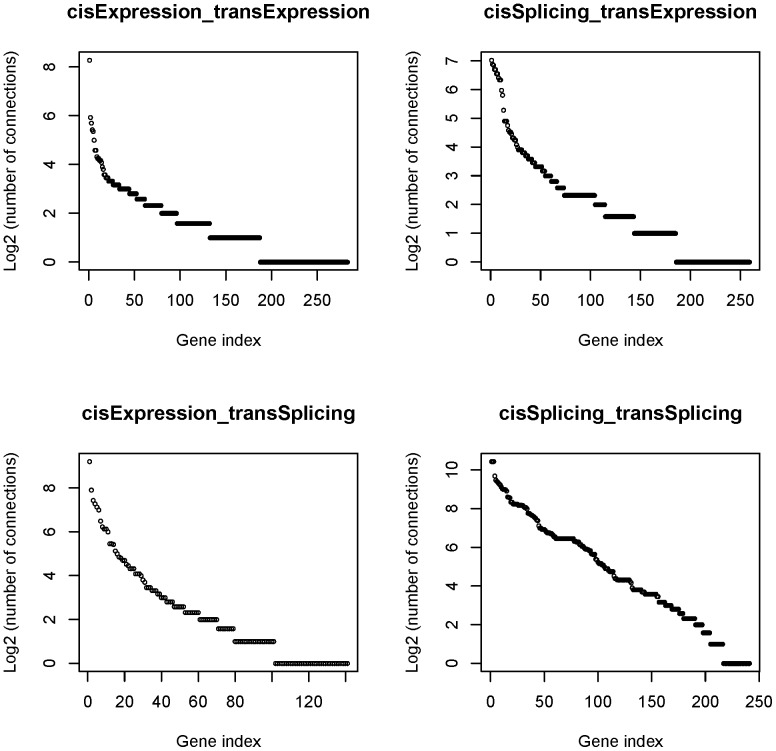
The uneven distributions of the regulated target genes.In drawing the plots, cis- located eQTL (sQTL) genes (regulators) are ordered by the numbers of their trans- located target genes and each of them is assigned an integer index (1, 2, 3,...).